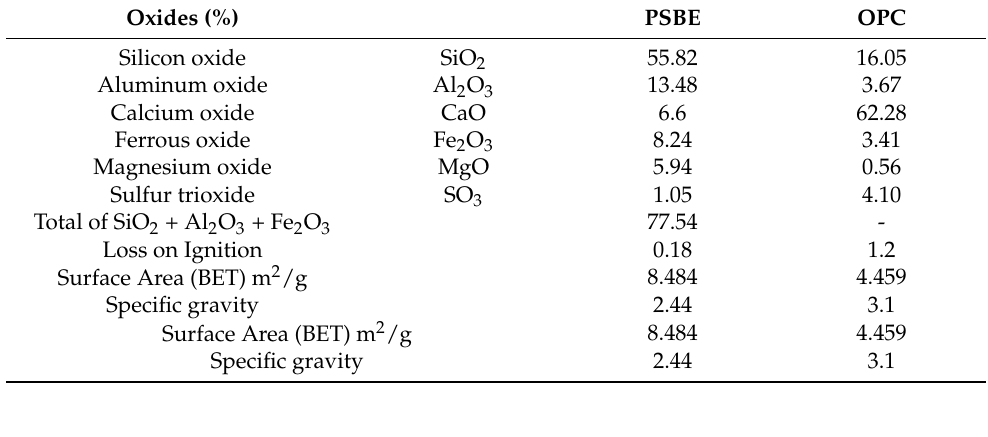
Table 1. Chemical composition of the OPC and PSBE.